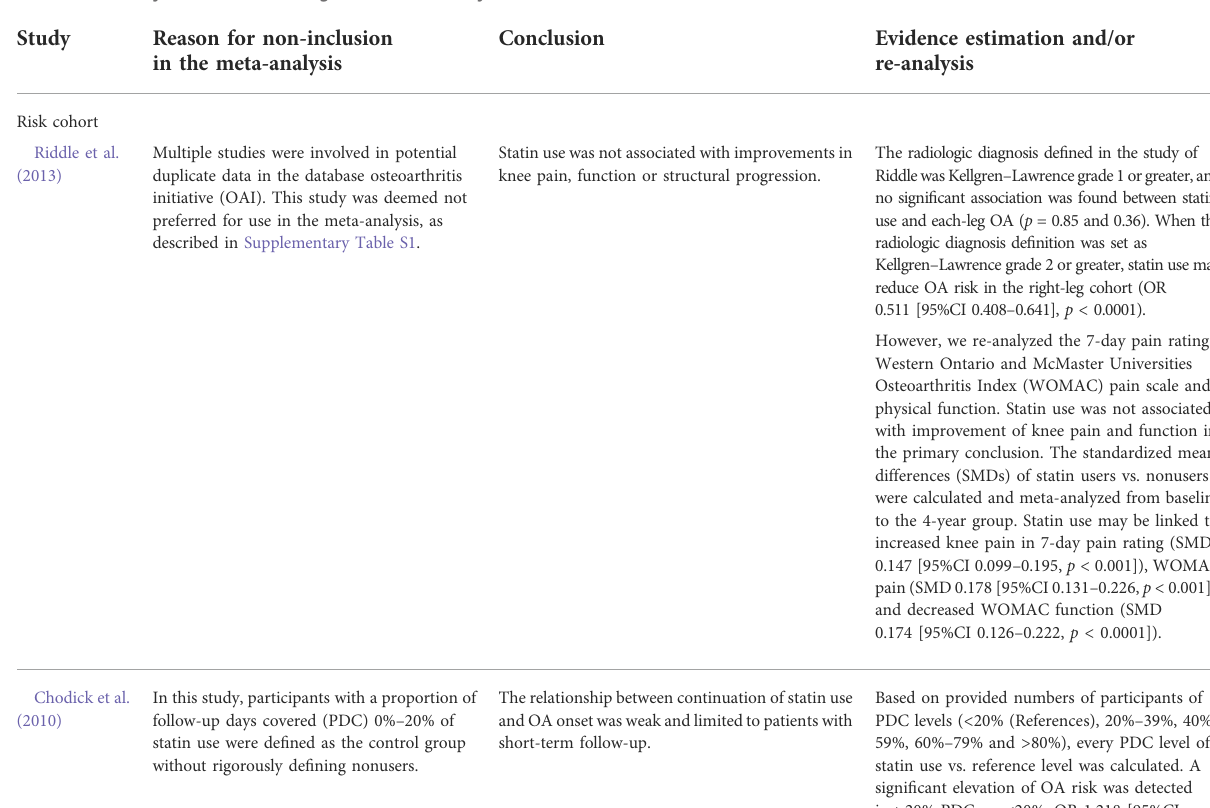
TABLE 3 Re-analysis of the data ineligible for